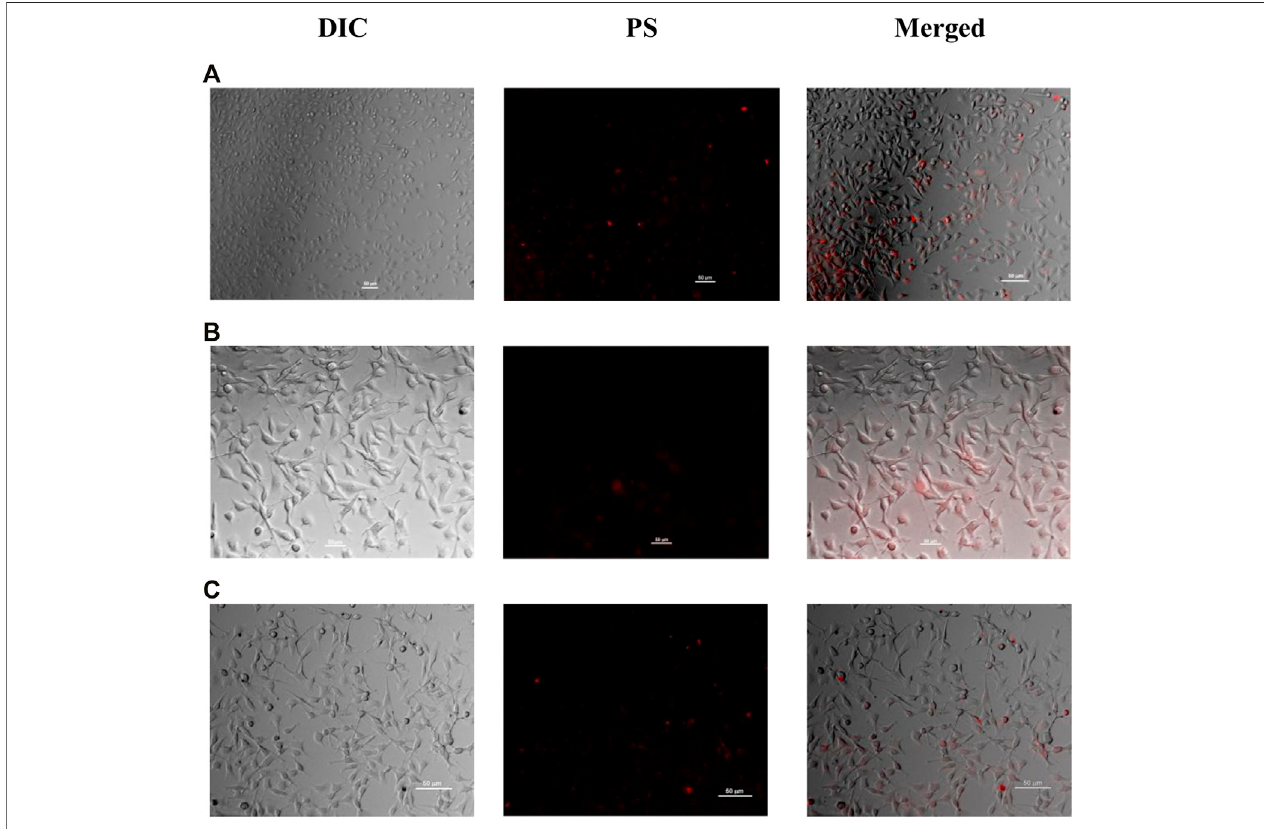
FIGURE5 | From left toright: differential interference contrast (DIC) and fl uorescence microscopy images of B16F10 cells treated with (A) ZnPc 1 , (B) ZnPc 2 , and (C) ZnPc 3 . The images show the distribution of the ZnPc dyes (10 μ M) in B16F10 cells after incubation for 4 h.